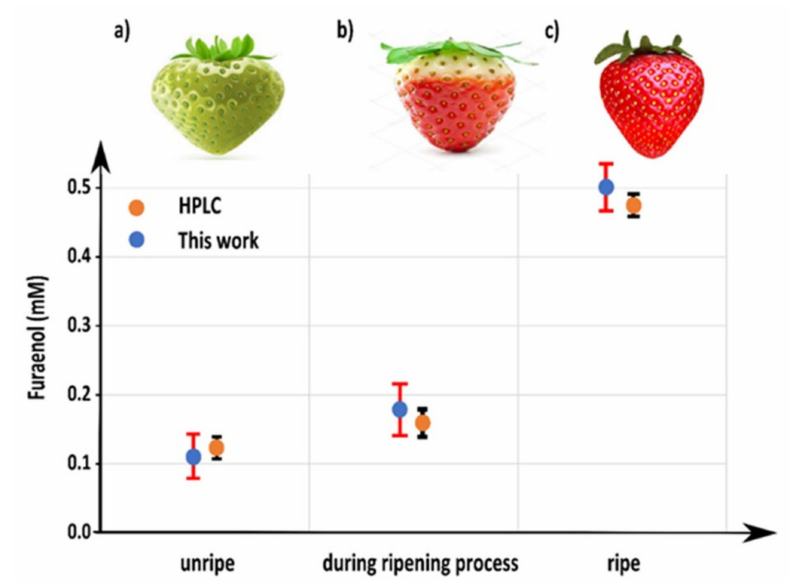
Figure 7. Validation of the aptasensor with HPLC by measuring furaneol in a real sample: ( a ) unripe strawberry, ( b ) during ripening process strawberry, and ( c ) ripe strawberry (tested samples n = 3).